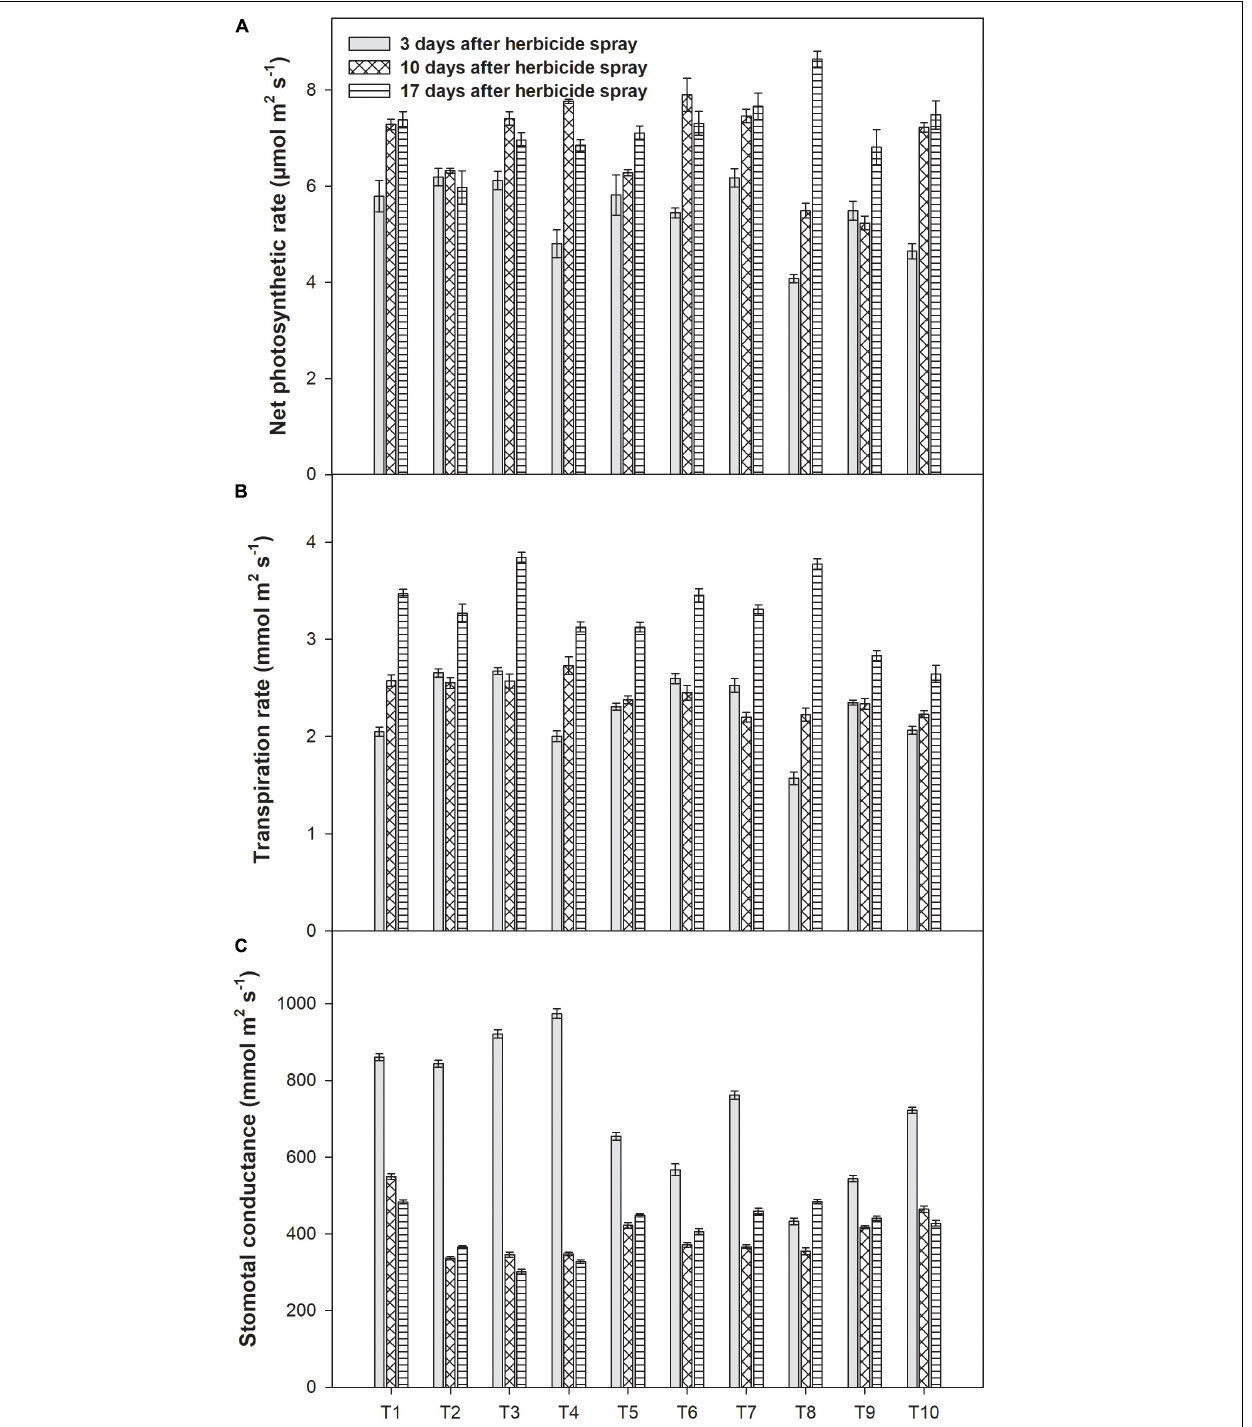
Frontiers in Plant Science |